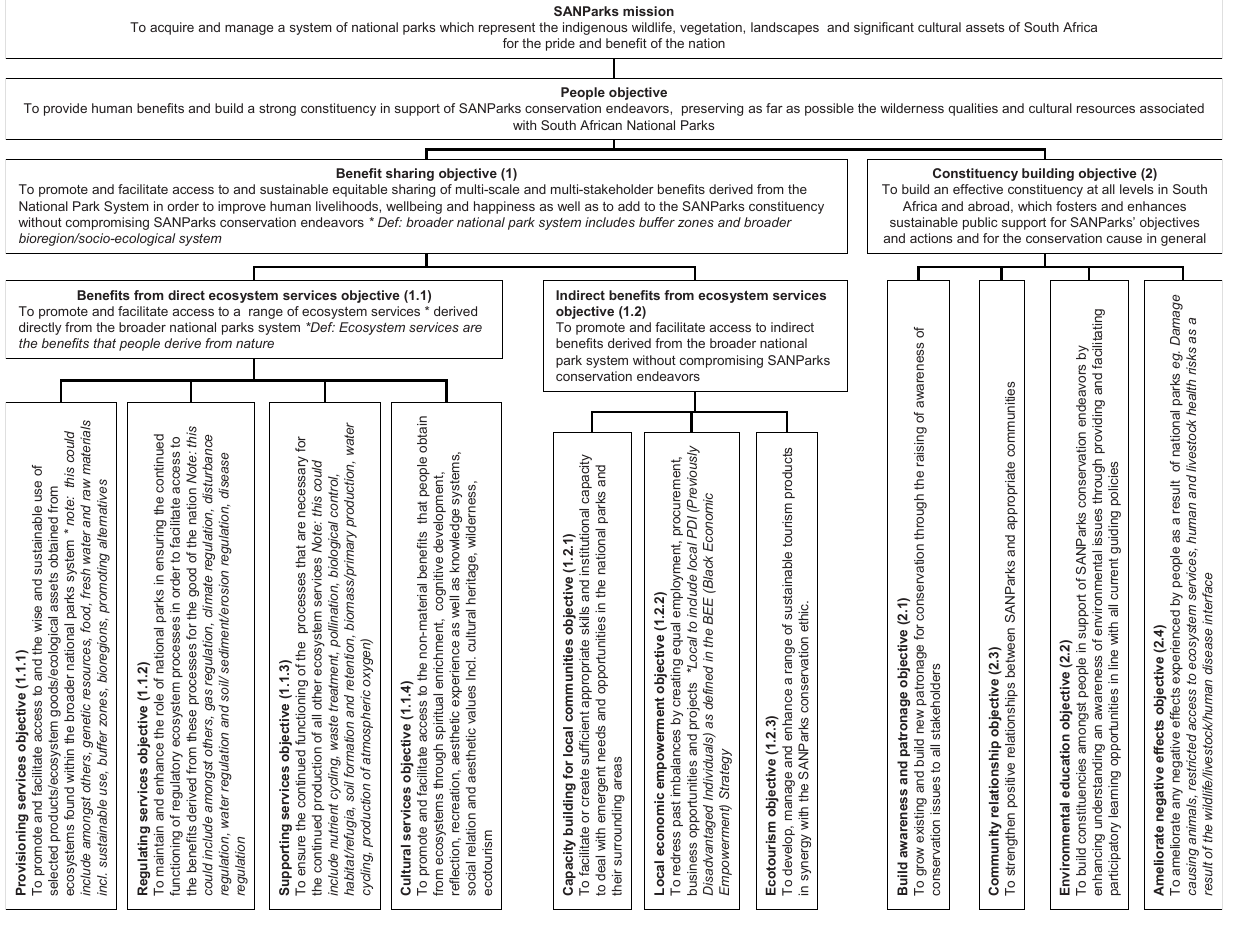
FIGURE 1: A diagrammatic representation of the draft high level management objectives for the people component of the South African National Parks (SANParks)